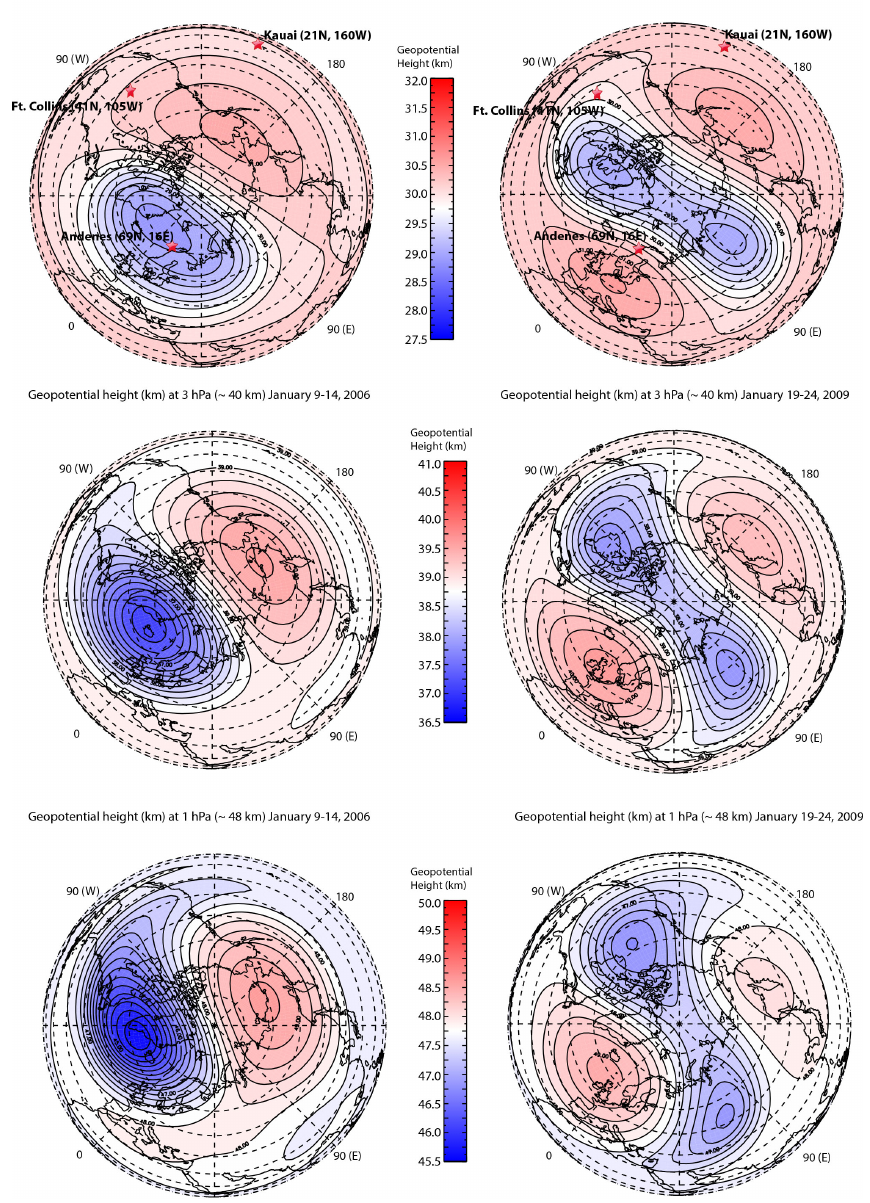
Figure 8. The geopotential height during 2006 SSW event (left panels) and 2009 SSW event (right panel) averaged between 9 and 14 January at (top panel) 10hPa ( ∼ 32km), (middle panel) 3hPa ( ∼ 40km) and (bottom panel) 1hPa ( ∼ 48km). The red star in Fig. 7a indicates locations for which temperature and mean winds are shown in Fig.